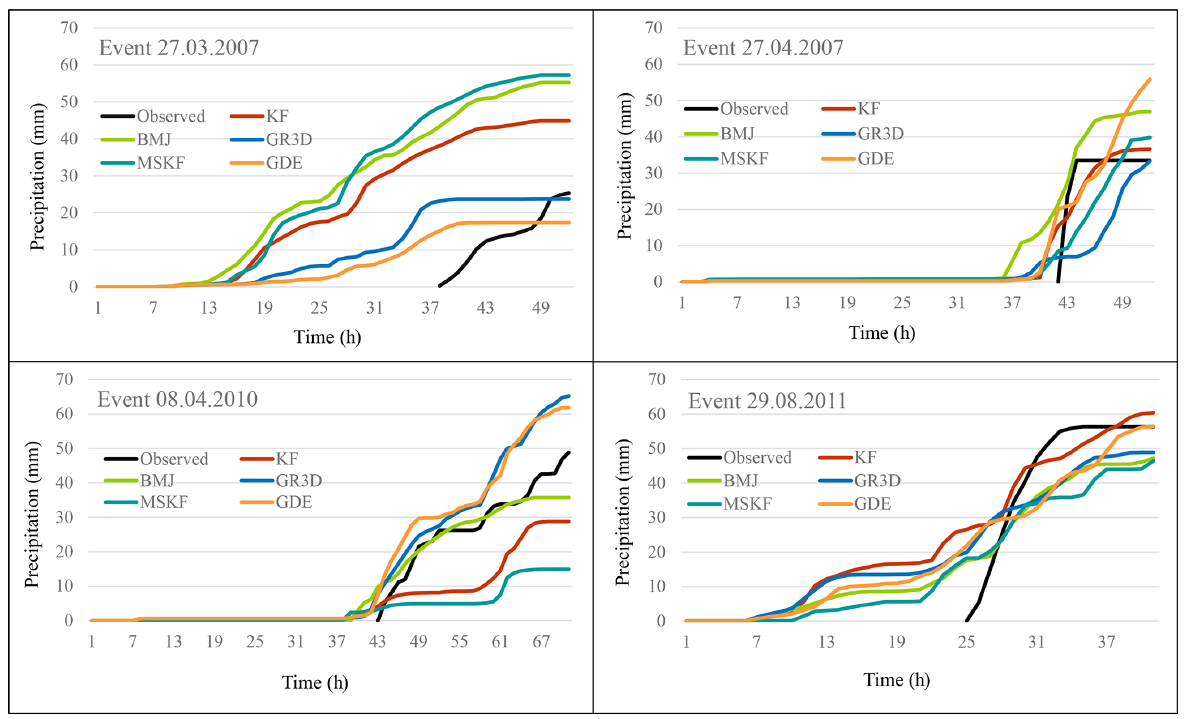
Figure 6. The ensemble forecasted precipitation and the observed cumulative